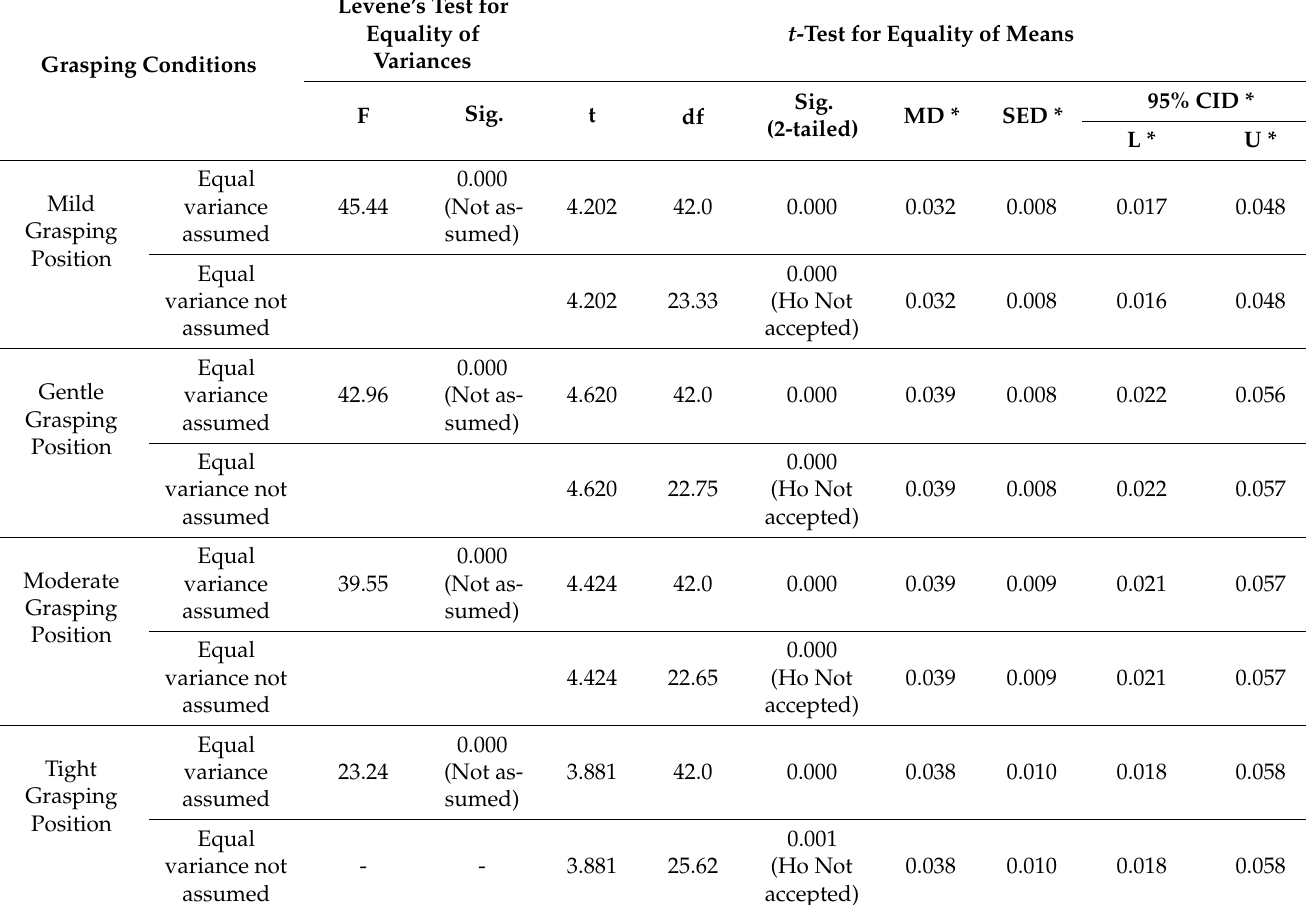
Table 6. Independent t -test for various grasping conditions at two different hand